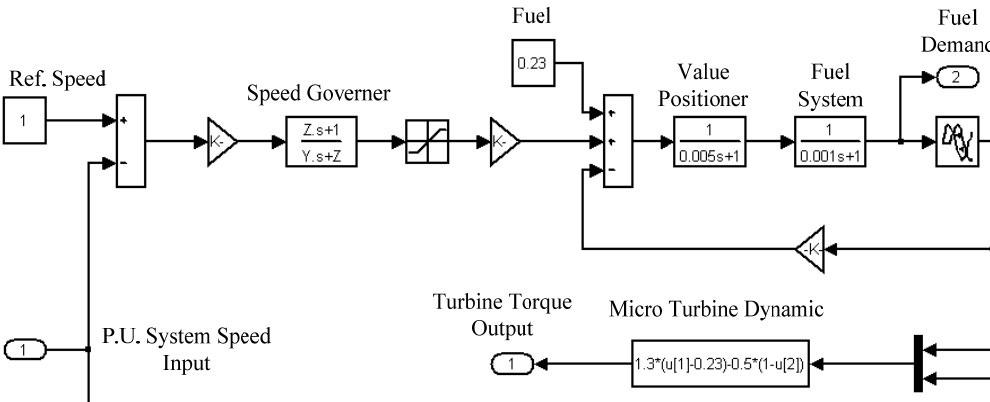
Figure A4. Model of gas